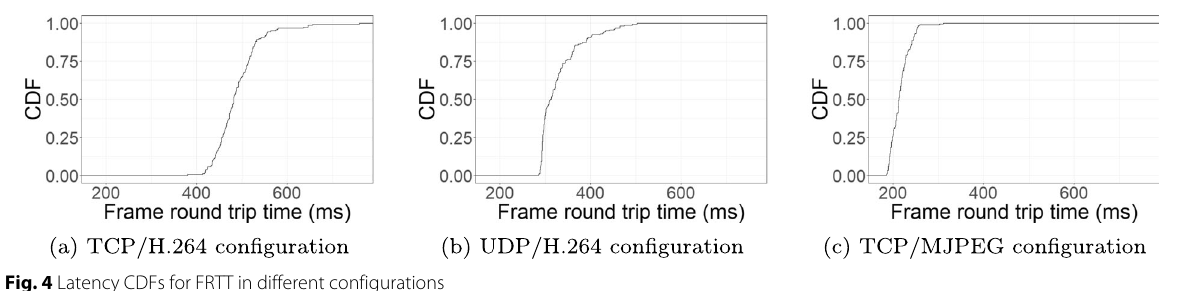
Fig. 4 Latency CDFs for FRTT in different configurations